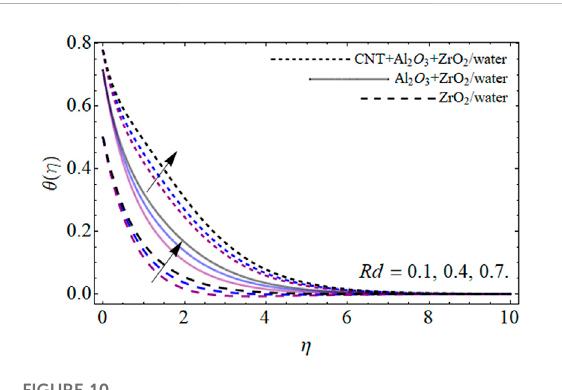
FIGURE 7 Energy outlines θ ( η ) versus thermal slip factor β .